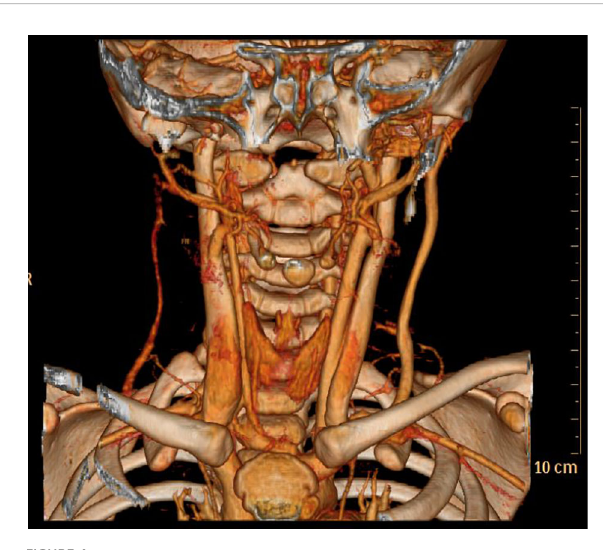
FIGURE 4 No. 8patientPost-treatment3D reconstruction,the hemangiomahas